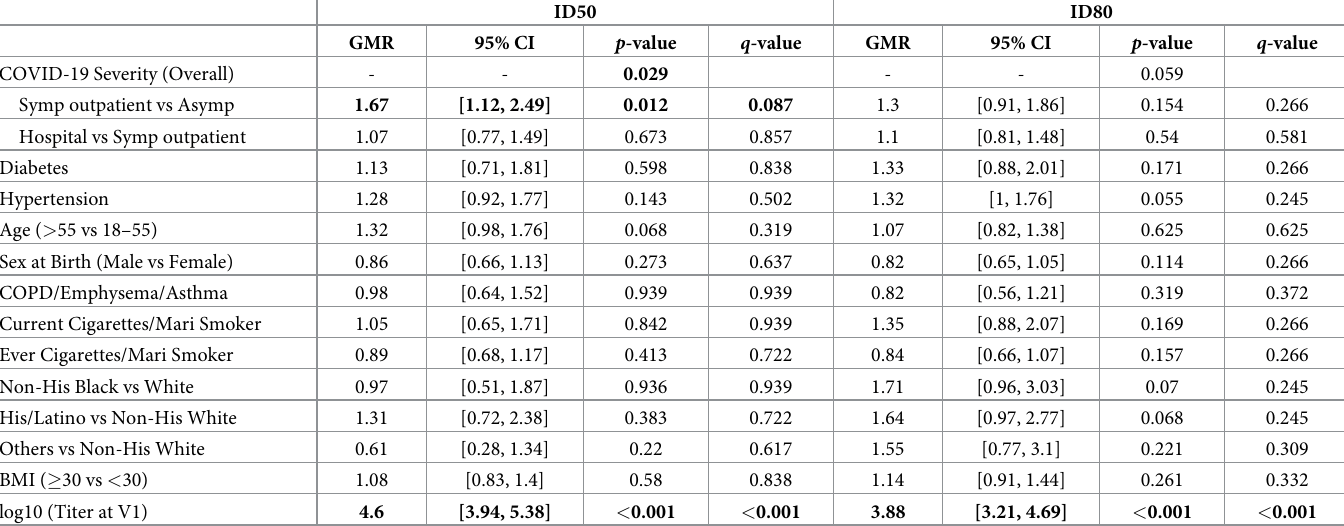
Table 3. Associations of COVID-19 severity, medical history, demographics, days since the first SARS-CoV-2 infection evidence, and ID50/ID80 titer at V1 with titer at V2 among participants with data available at both time points.